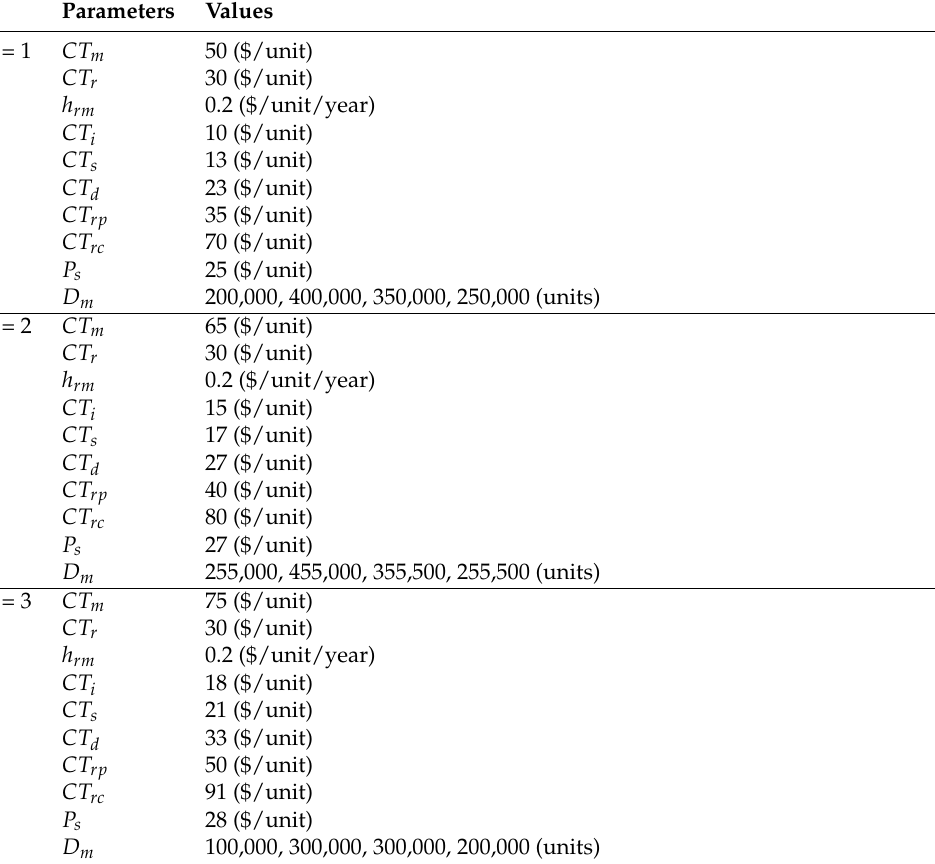
Table 2. Values of